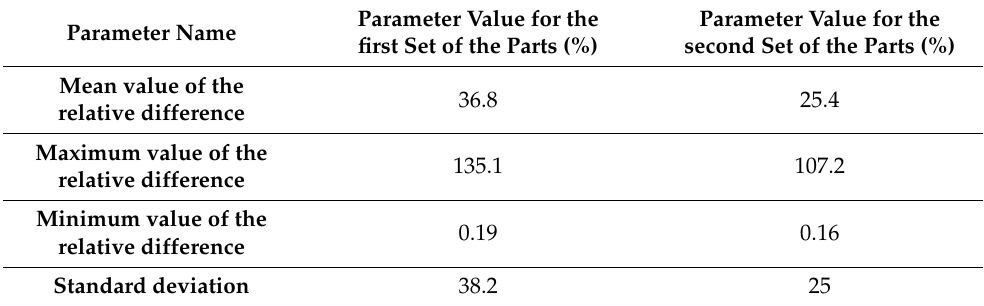
Table 3. Statistical parameters of the relative difference between results obtained by new and traditional methods for the first set of parts.